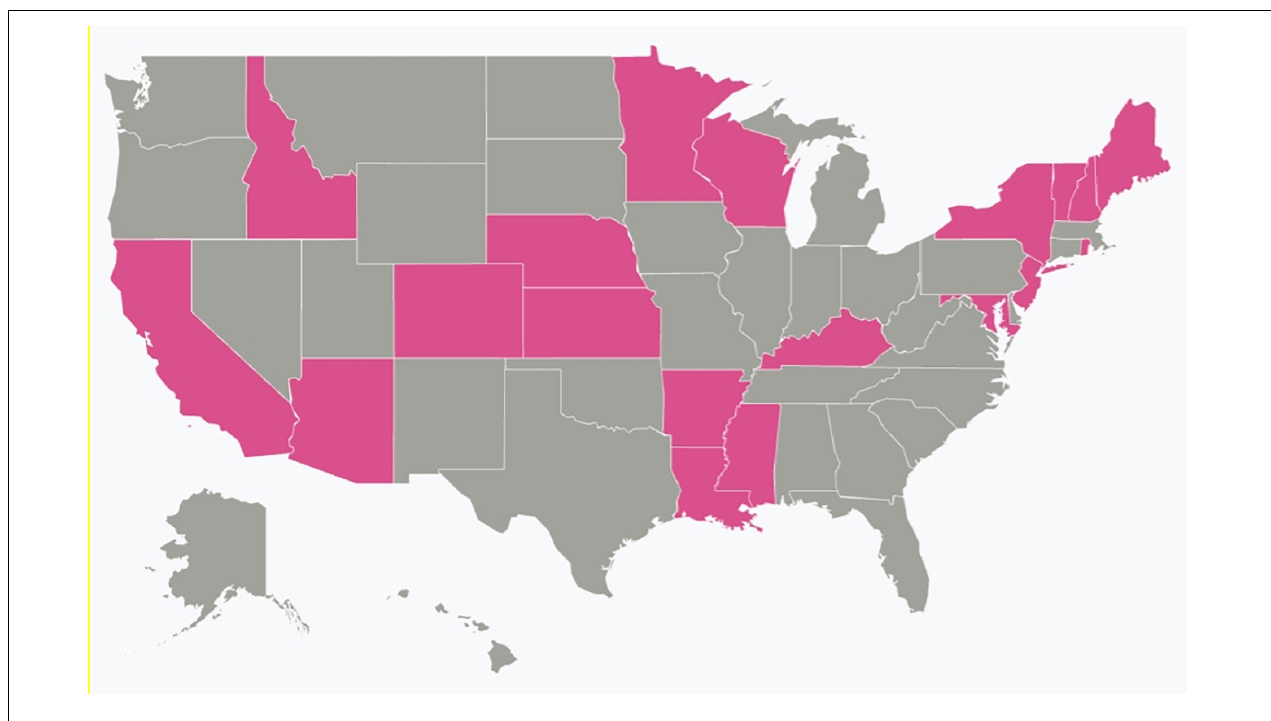
FIGURE 1 | Map of States that have Adopted Unchanged/New Flex